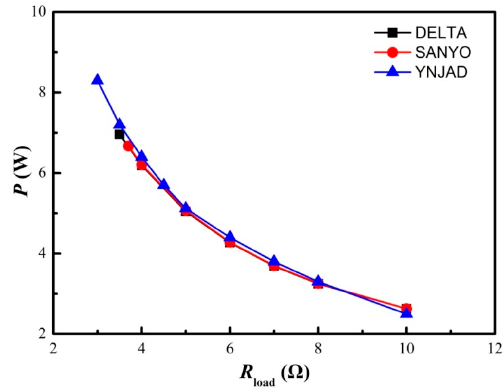
Figure 9. Influence of cooling fan selection on STEG output power performance (HS1 heat sink, Cod1 heat conducting plate and Cof1 configuration).